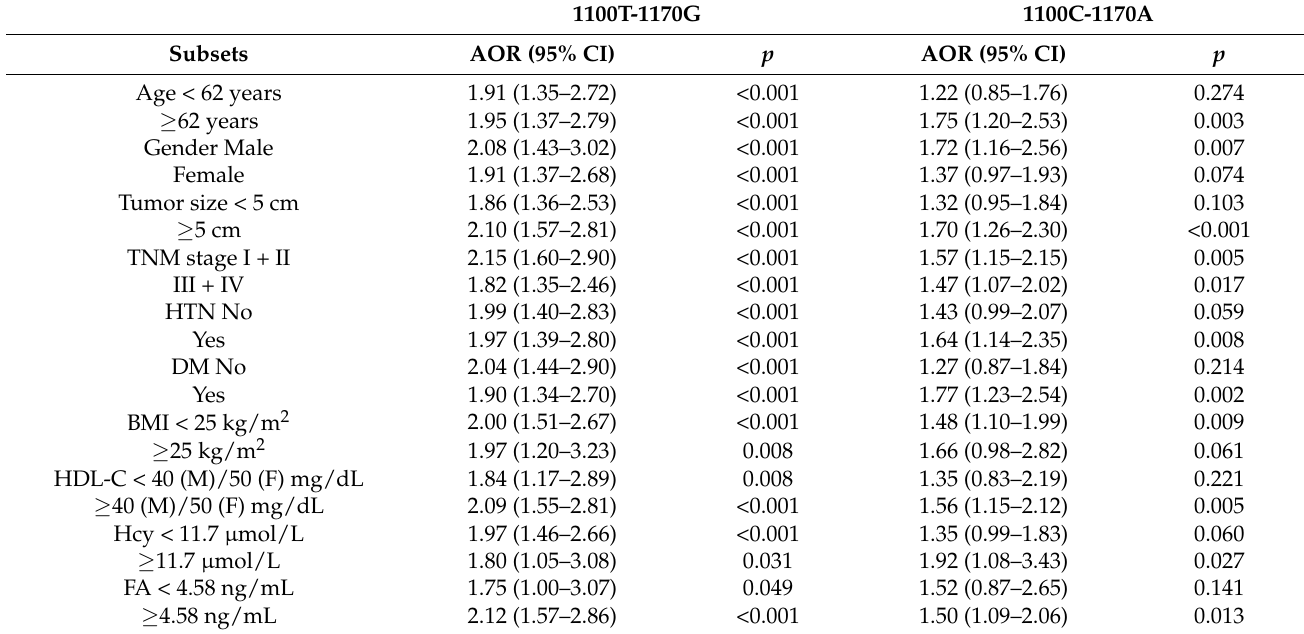
Table 5. Analysis of CRC incidence and association in haplotypes of TS